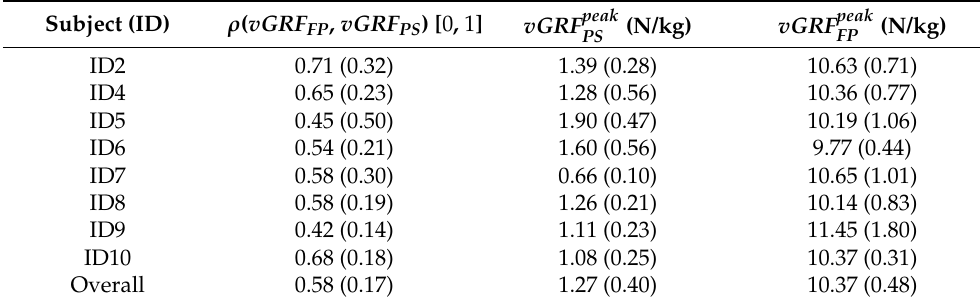
Figure 8. Mean and standard deviation profiles of vGRF (normalized to subject’s weight) and CoPy recorded for each participant (ID). For each ID, mean velocity and standard deviations are shown on the right, as well as their body mass. Yellow and grey data show PS and FP results, respectively. For the vGRF profiles, the y -axis on the left of the figure is relative to the FP estimate, while the y -axis on the right is for PS estimates. For each ID, all the strides are considered. For the CoPy profiles, the y -axis is common for both the FP and PS estimates. Table 3. Median (IQR) of the correlation coefficients between the vGRF estimated by the pressure sensors and the one recorded from the force platform, ρ ( vGRF FP , vGRF PS ), and peak vGRF for both pressure sensors and the force platform ( vGRF peak , vGRF peak ), for each subject (ID). FP PS